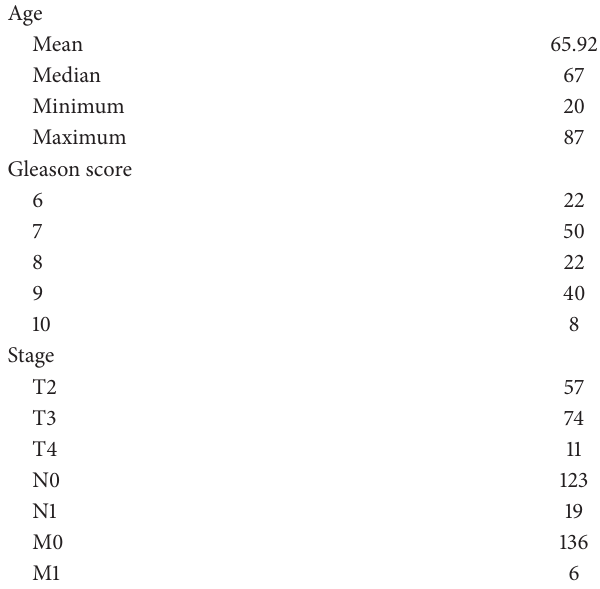
Table 1: Patient age and tumor characteristics of the